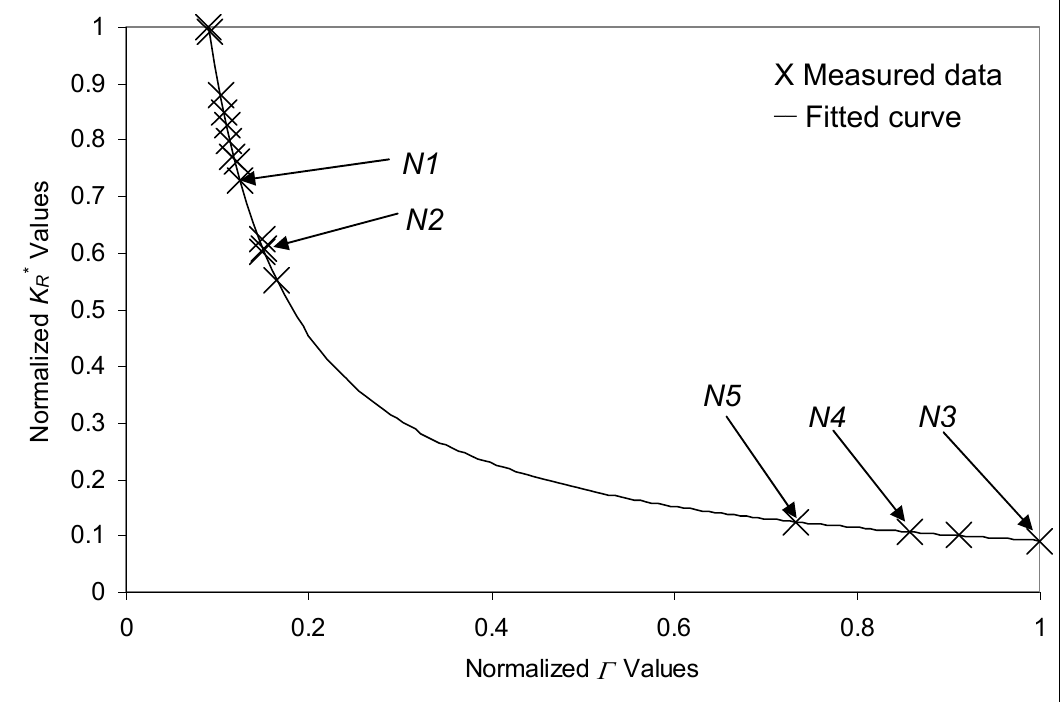
Figure 7. Calculated (from experiment and measured values) and fitted curve changes in the rotational stiffness K R* values as a function of the geometry of the cantilever. The values for the nominal ideal geometry cantilevers are pointed